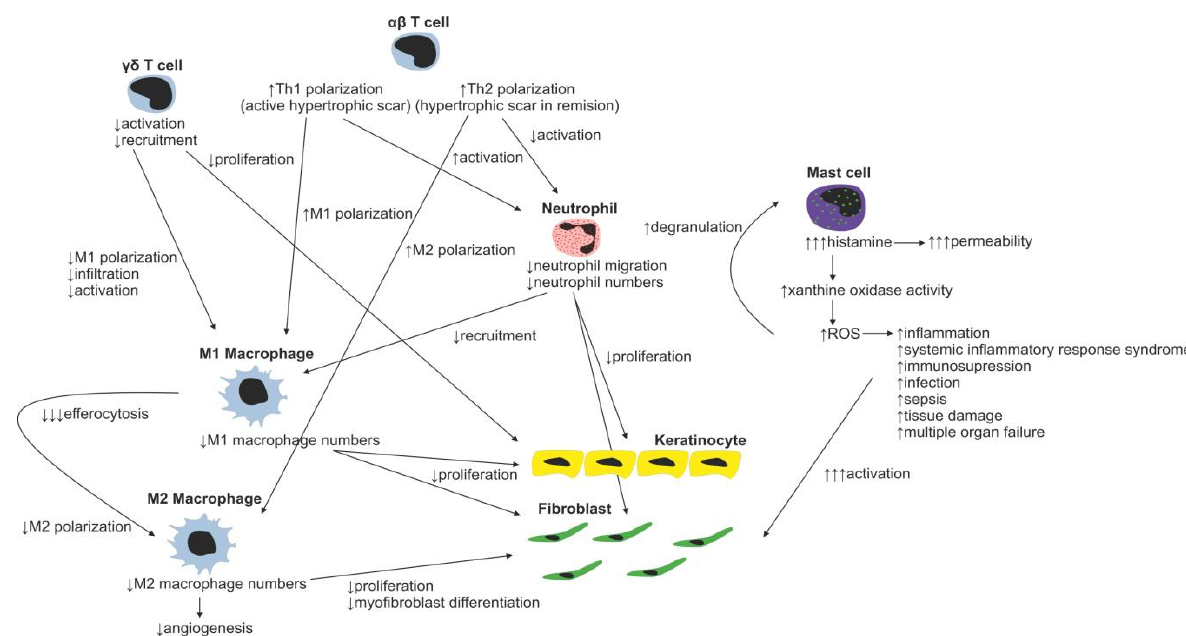
Figure 4. Changes in immune cell regulation of wound healing following burn injury. During normal skin wound healing, neutrophils are replaced by macrophages within a few days. The major source of wound-related macrophages is the pool of circu- lating monocytes in the blood vessels, which enter the injury site through vascular leak- age, whereas skin-residing macrophages represent the minor source [36–38]. At the in- jury site, residing macrophages are polarized to inflammatory phenotype, sometimes